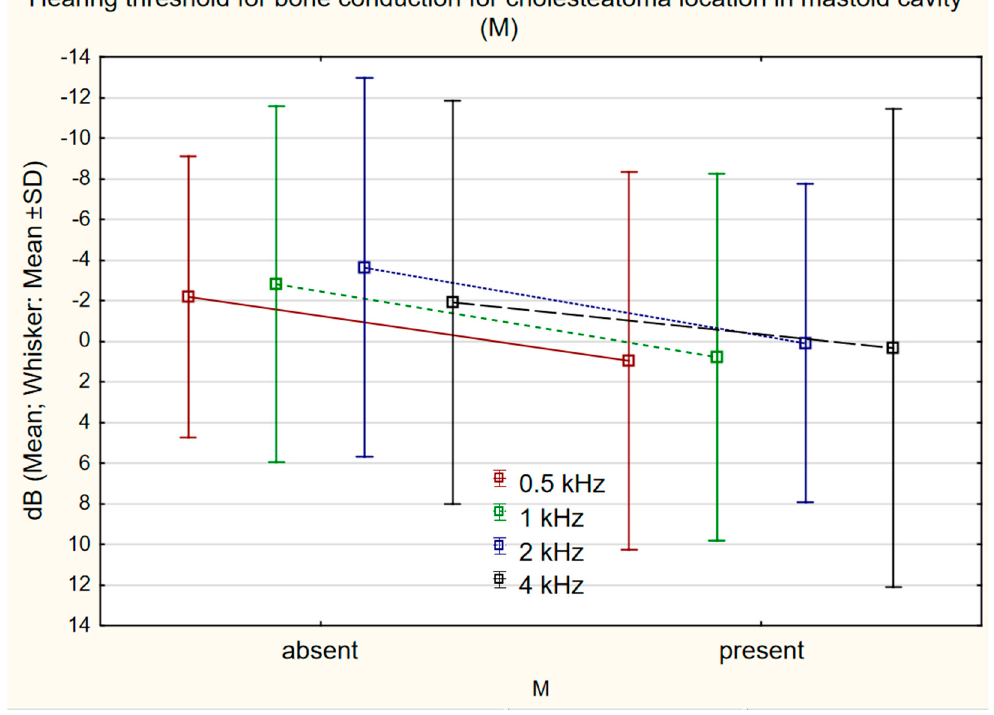
Figure 4. The difference in bone conduction prior to surgery and 1 year after surgery in presence ( n = 58) or absence ( n = 62) of cholesteatoma in the mastoid cavity (M) at 0.5 kHz 0.95 dB (SD 9.29)/ − 2.18 dB (SD 6.93) ( p = 0.024), 1 kHz 0.76 dB (SD 9.02)/ − 2.82 dB (SD 8.76) ( p = 0.032), 2 kHz 0.09 (SD 7.86)/ − 3.36 (SD 9.33) ( p = 0.039).